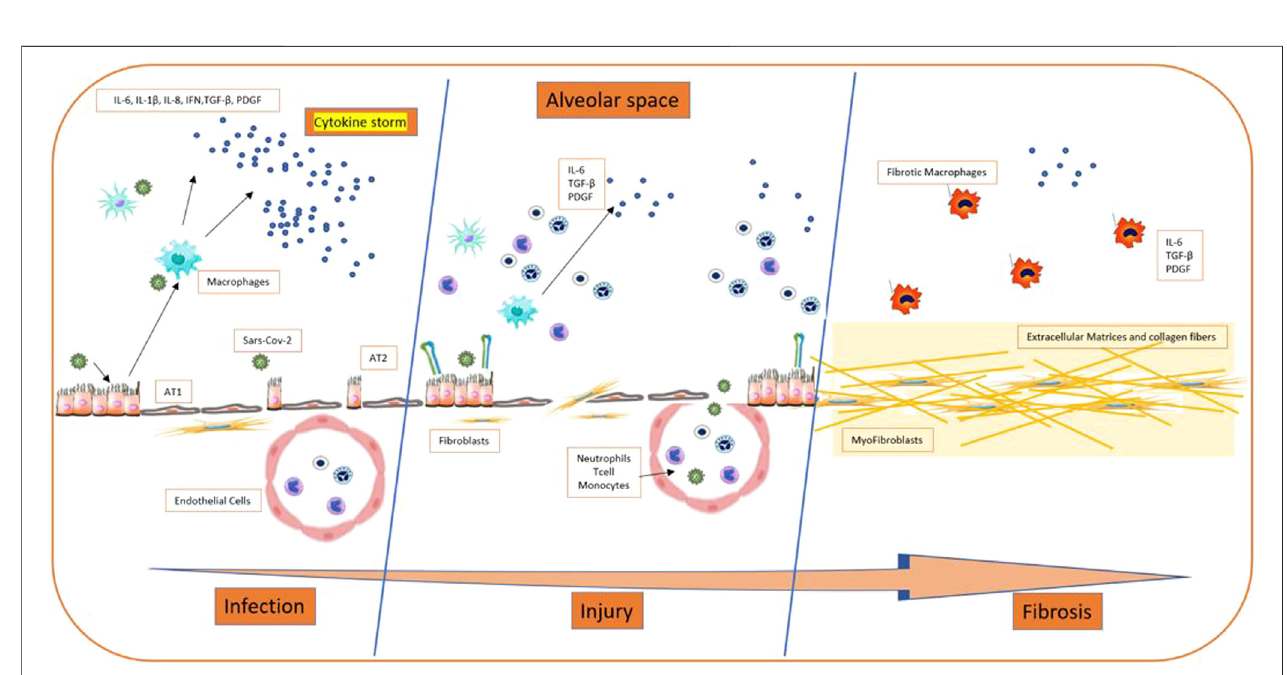
FIGURE 4 | Process of development of fi brosis on Sars COV-2